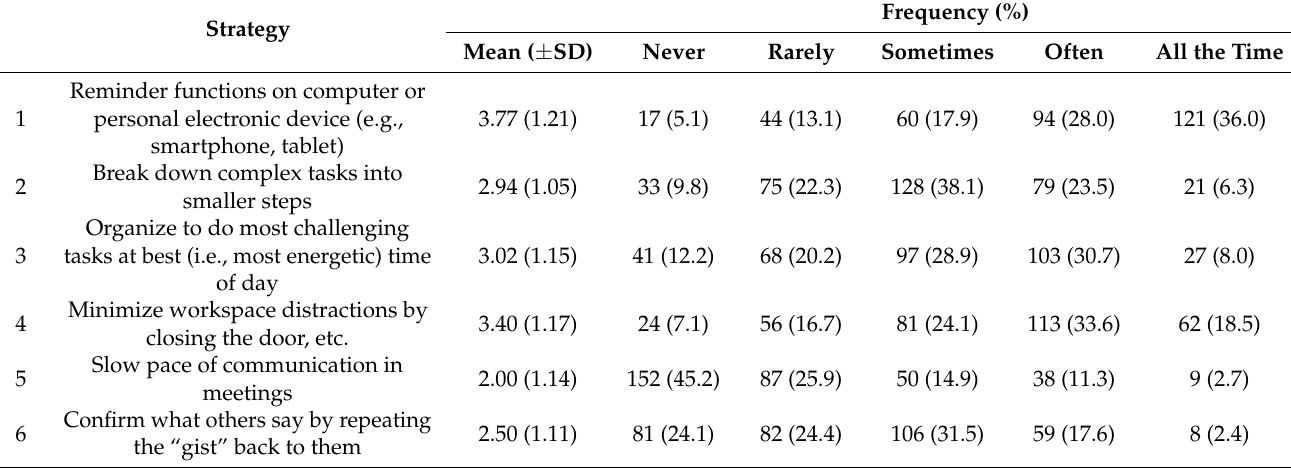
Table 2. Descriptive statistics, self-reported engagement in compensatory cognitive strategies: Com- pensatory Cognitive Strategies Scale frequency and